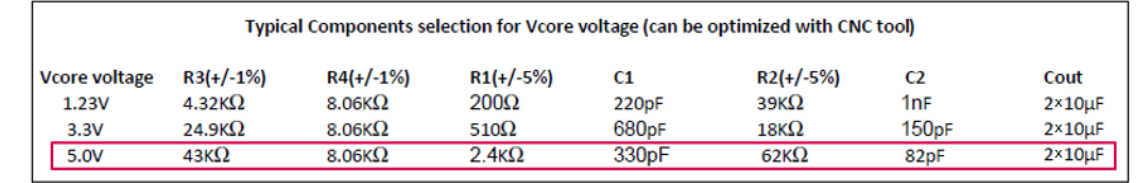
Figure 6. Typical values recommended by the F6512 SBC datasheet.